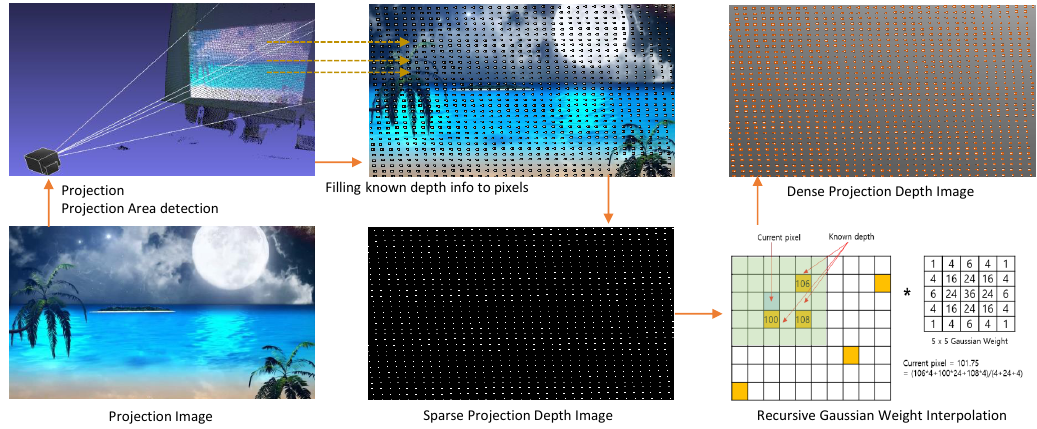
Figure 7. An example of generation of the dense projection depth image by recursive Gaussian weight